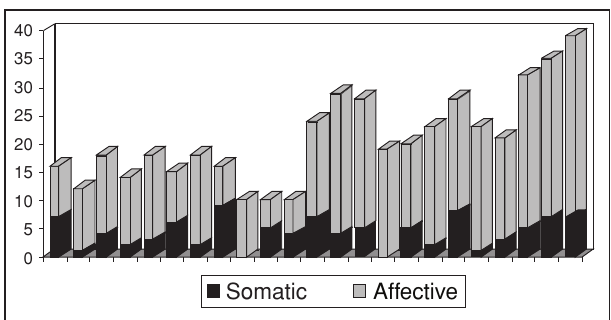
Fig. 2. Distribution of BDI scores (somatic and affective com- ponent) in the depressed subgroup of